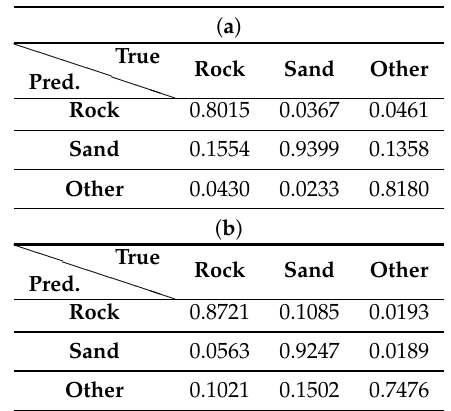
Table 4. Confusion matrices for MCM normalized ( a ) column-wise ( b )